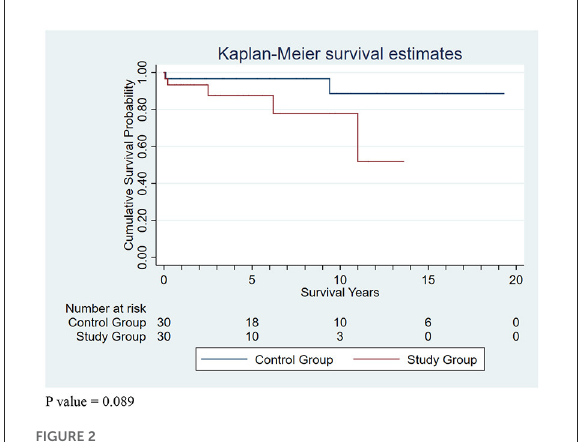
FIGURE2 Kaplan-Meier survival curves for study group and control group. P -value =